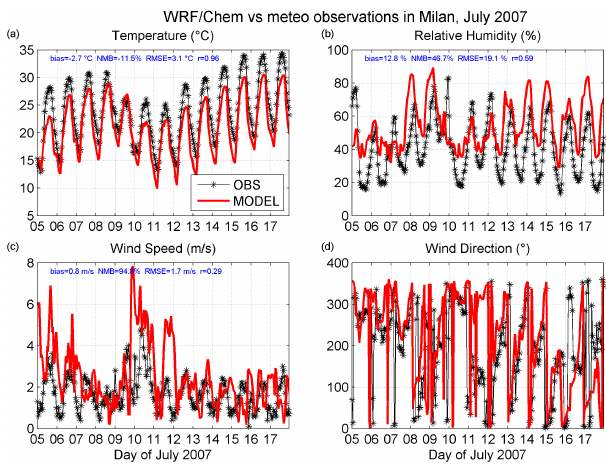
Figure 2. Comparison of observed and simulated hourly meteoro- logical variables at ground level in Milan on 5–17 July 2007. Simu- lations are carried out with WRF/Chem model and results are shown for the nested domain over northern Italy at a 10km horizontal reso- lution. Statistical indices shown in the inset are defined in Appendix